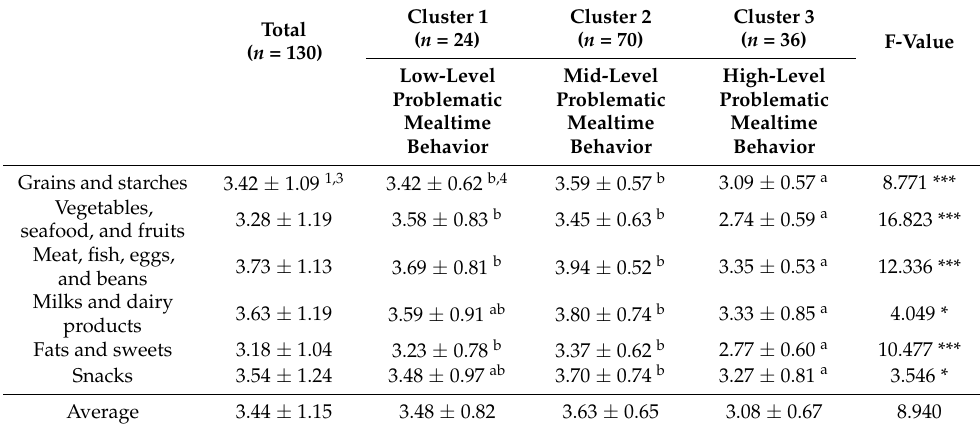
Table 7. Preference for food groups by ASD students’ mealtime behavior clusters 2 .